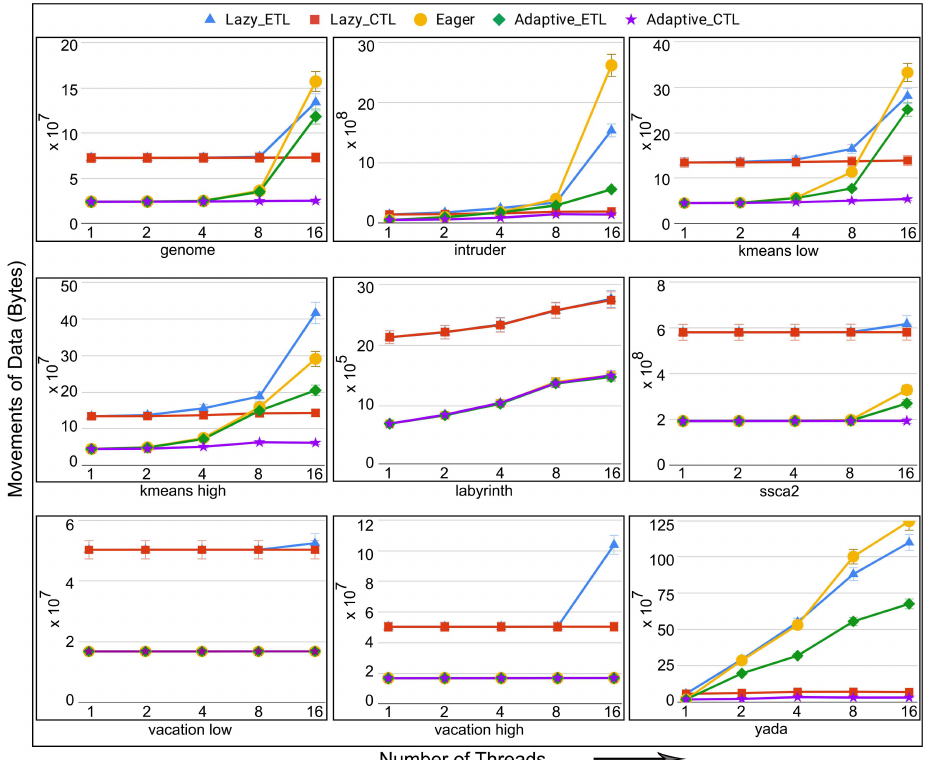
Figure 10. Data movements in STAMP benchmarks executing in persistent TM.